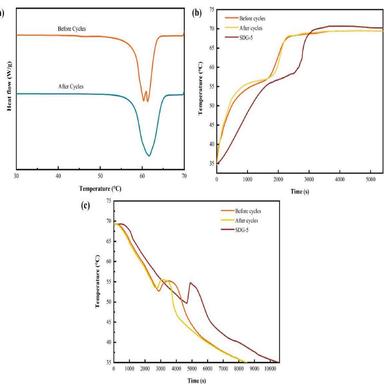
The thermal properties of BNCA/SDG composite PCMs. (a) DSC curves; (b–c) heating and cooling curves.